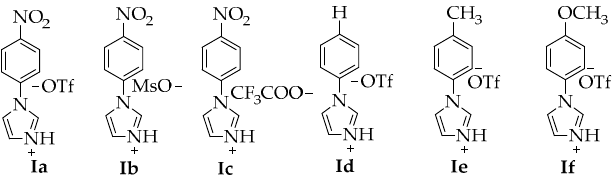
Table 1. Optimized condition of per- O -acetylation without solvent.